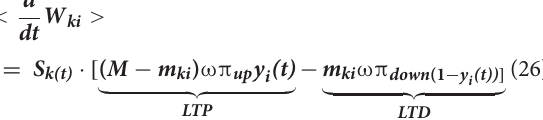
{0, 1,..., M } in Equation (26) represents the number of active synapse is controlled by pre- and postsynaptic activity. An input pulse ( Figure 13A ) of the i th input is defined by y i (t) = 1 [and no presynaptic pulse by y i (t) = 0] and t fk denotes the spike time of the f th spike of postsynaptic neuron Z k . A neuron Dirac delta pulses δ ( · ) at the spike times: S k (t) = P